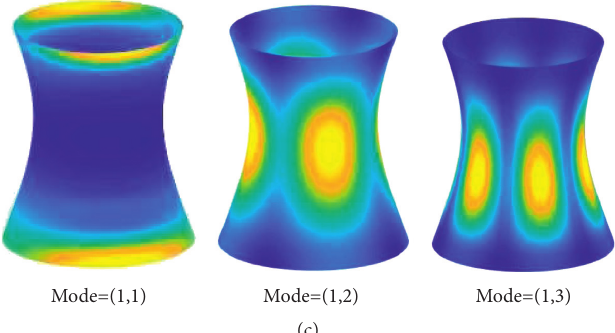
Figure 8: Several typical mode shapes for Sandwich FGP hyperbolic shell. (a) Hyperbolic shell ( c � 1) with E1-E1 boundary conditions. (b) Hyperbolic shell ( c � 2) with E2-E2 boundary conditions. (c) Hyperbolic shell ( c � 3) with E3-E3 boundary conditions.